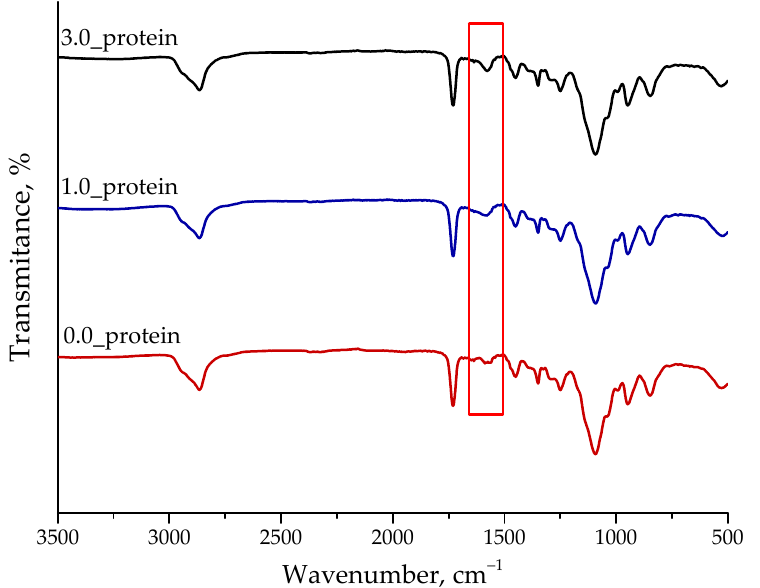
Figure 8. FT-IR spectra of unmodified hydrogel (sample 0.0_protein, red) and hydrogels containing protein particles (i.e., samples: 1.0_protein (blue) and 3.0_protein (black)).